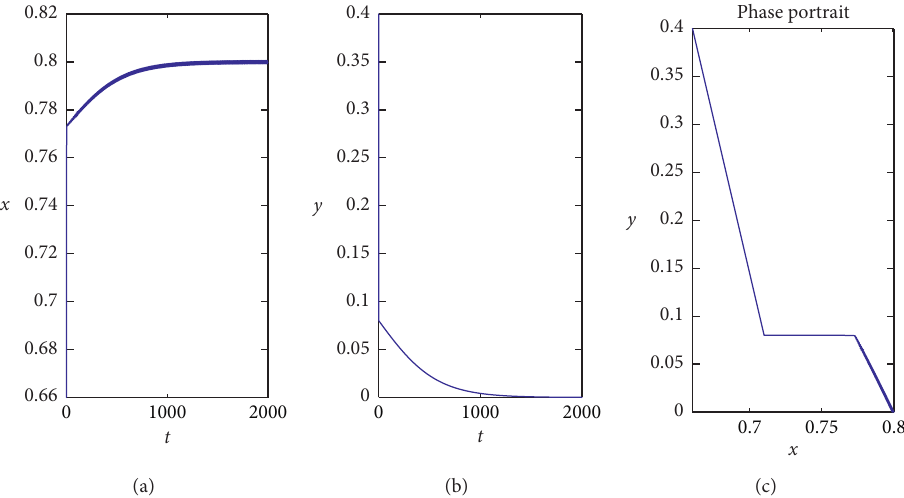
Figure 8: The predator species tends to be extinct for system (11) with p �